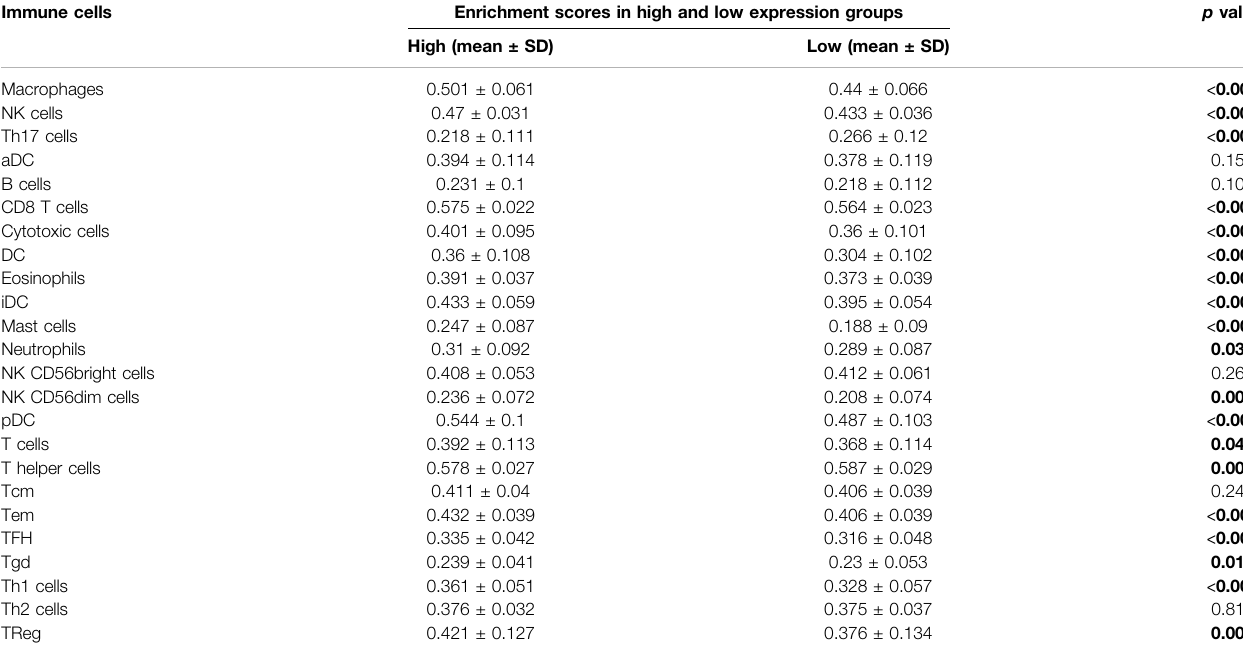
Bold indicates statistically signi fi cant, that is, a p value less than